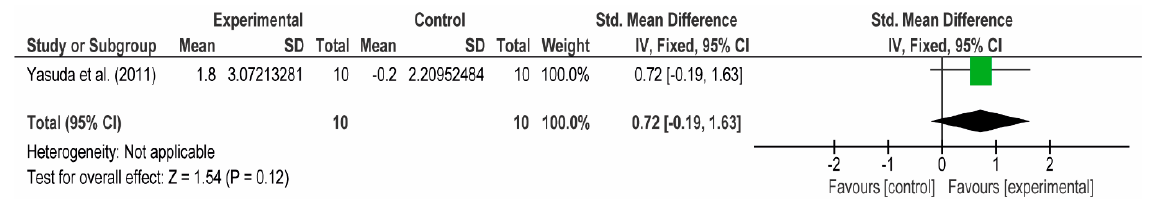
Figure 7. The effect size of 6-weeks of lying triceps extension exercise (sequential concentric and Figure 7. The effect size of 6 -weeks of lying triceps extension exercise (sequential concentric and Figure 7. The effect size of 6 -weeks of lying triceps extension exercise (sequential concentric and Figure 7. The effect size of 6 -weeks of lying triceps extension exercise (sequential concentric and Figure 7. The effect size of 6 -weeks of lying triceps extension exercise (sequential concentric and Figure 7. The effect size of 6 -weeks of lying triceps extension exercise (sequential concentric and eccentric elbow extensions) on the triceps brachii long head MT. eccentric elbow extensions) on the triceps brachii long head MT. eccentric elbow extensions) on the triceps brachii long head MT. eccentric elbow extensions) on the triceps brachii long head MT. eccentric elbow extensions) on the triceps brachii long head MT. eccentric elbow extensions) on the triceps brachii long head MT.